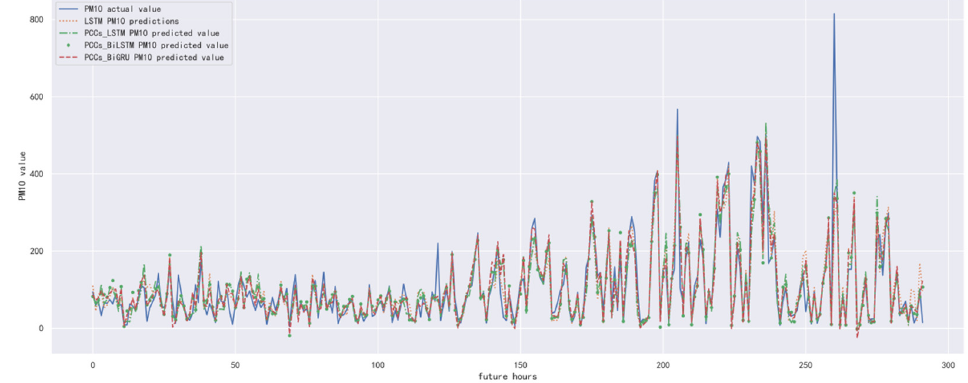
Figure 17. The schematic diagram of predicted PM 10 concentration in the next two hours.